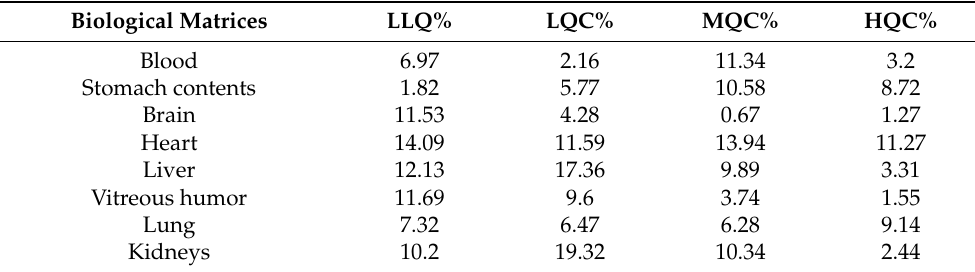
Table 8. Lower limit of quantification (LLQ), low-quality control (LQC), medium-quality control (MQC), and high-quality control (HQC) calculated in each matrix, in triplicate, intracutaneous and intercurrent to aldicarb.